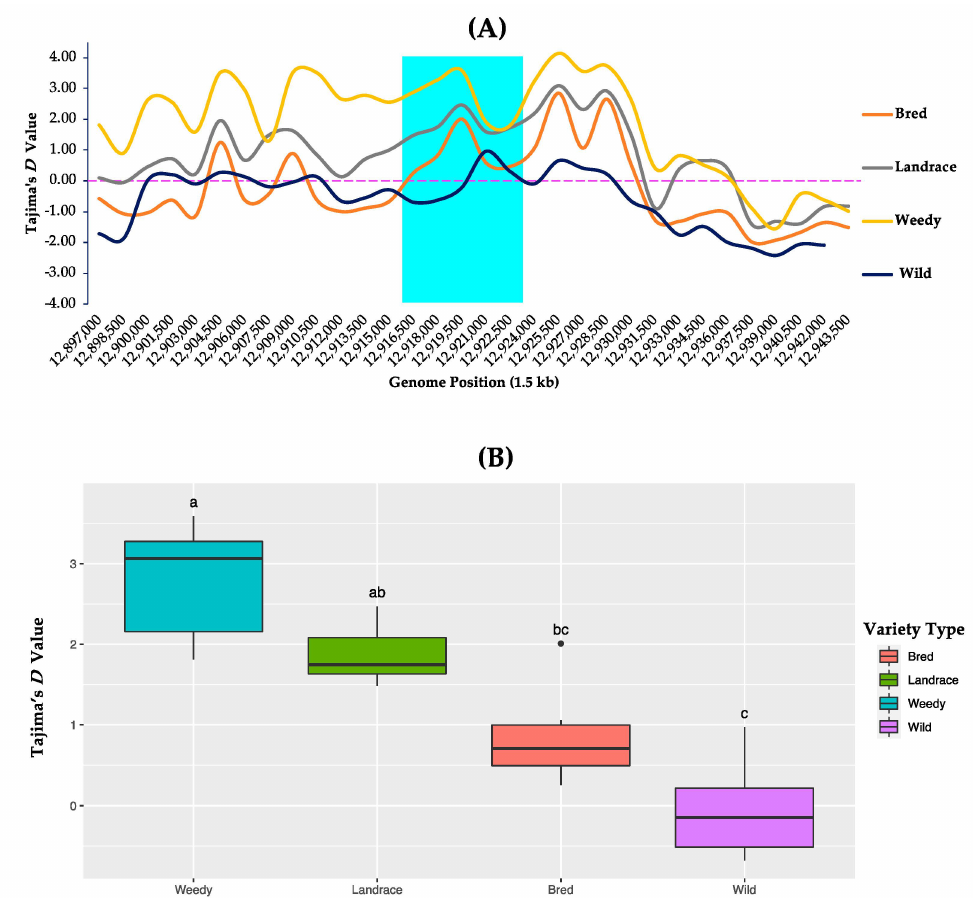
Figure 4. Tajima’s D values of GBSSII ( Os07g0412100 ) in the 475 Korean rice accessions by means of variety types (landrace, weedy, and bred) together with the wild. ( A ) Tajima’s D values, representing different individual segregating sites within the GBSSII gene region in the 1.5 kb sliding window. Cyan indicates the GBSSII gene region, and each colored line represents a different rice variety type. ( B ) Box plots represent different distribution patterns of the GBSSII genetic variations according to the Tajima’s D values among the variety types. Different lowercase letters (a, ab, bc and c) indicate a significant difference level at p -value <